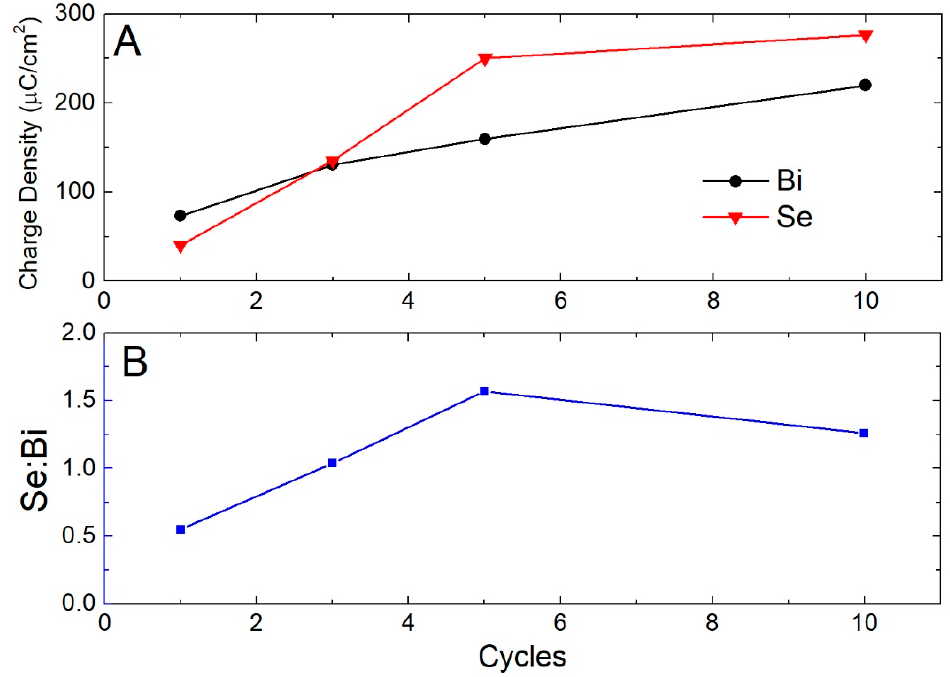
Figure 5. ( A ) Stripped charge, from samples with up to 10 layers, before of the Bi (black) and then of the Se (red); ( B ) ratio between the quantity of Se and the Bi (ideal 1.5).